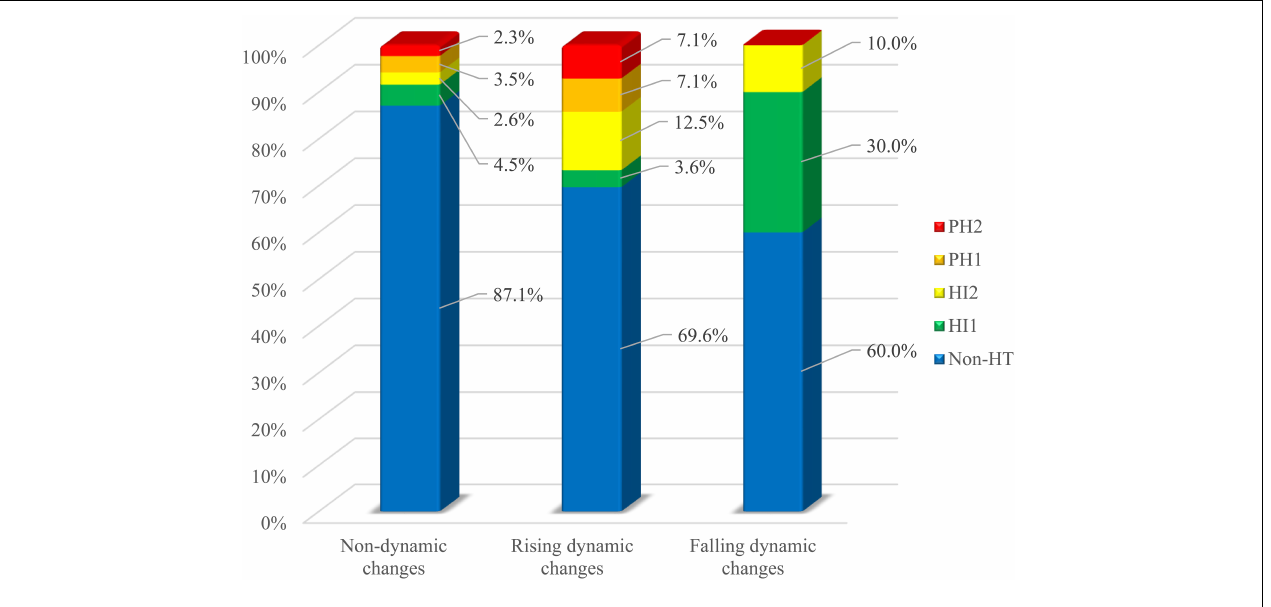
FIGURE 2 | Differences in HT between groups with non-dynamic, rising and falling dynamic changes. TABLE 3 | Logistic regression analysis to identify relationships between troponin elevation on admission, troponin dynamic changes and HT,